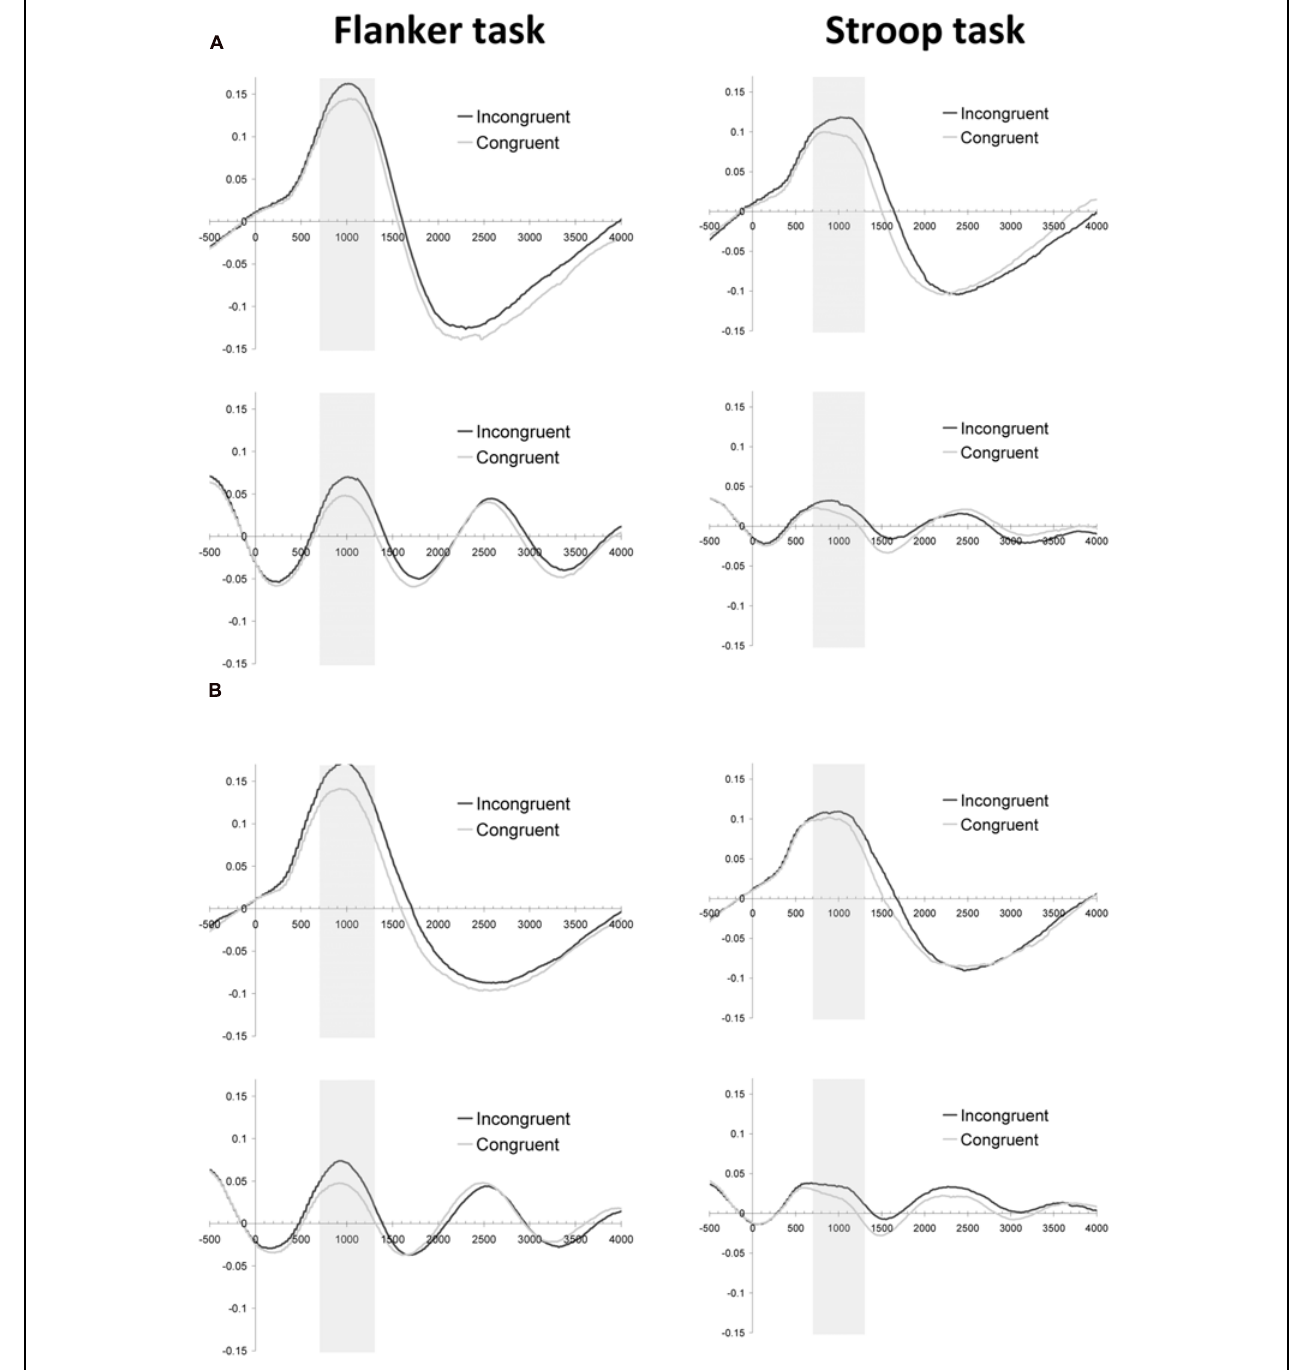
FIGURE 2 | Pupillary response (mm) as a function of time (ms) and current-trial congruency for Experiment 2 (A) and Experiment 3 (B). Both graphs depict baseline-corrected pupil dilation in the Flanker (left column) and Stroop (right column) task for filler trials (upper row) and test trials (lower